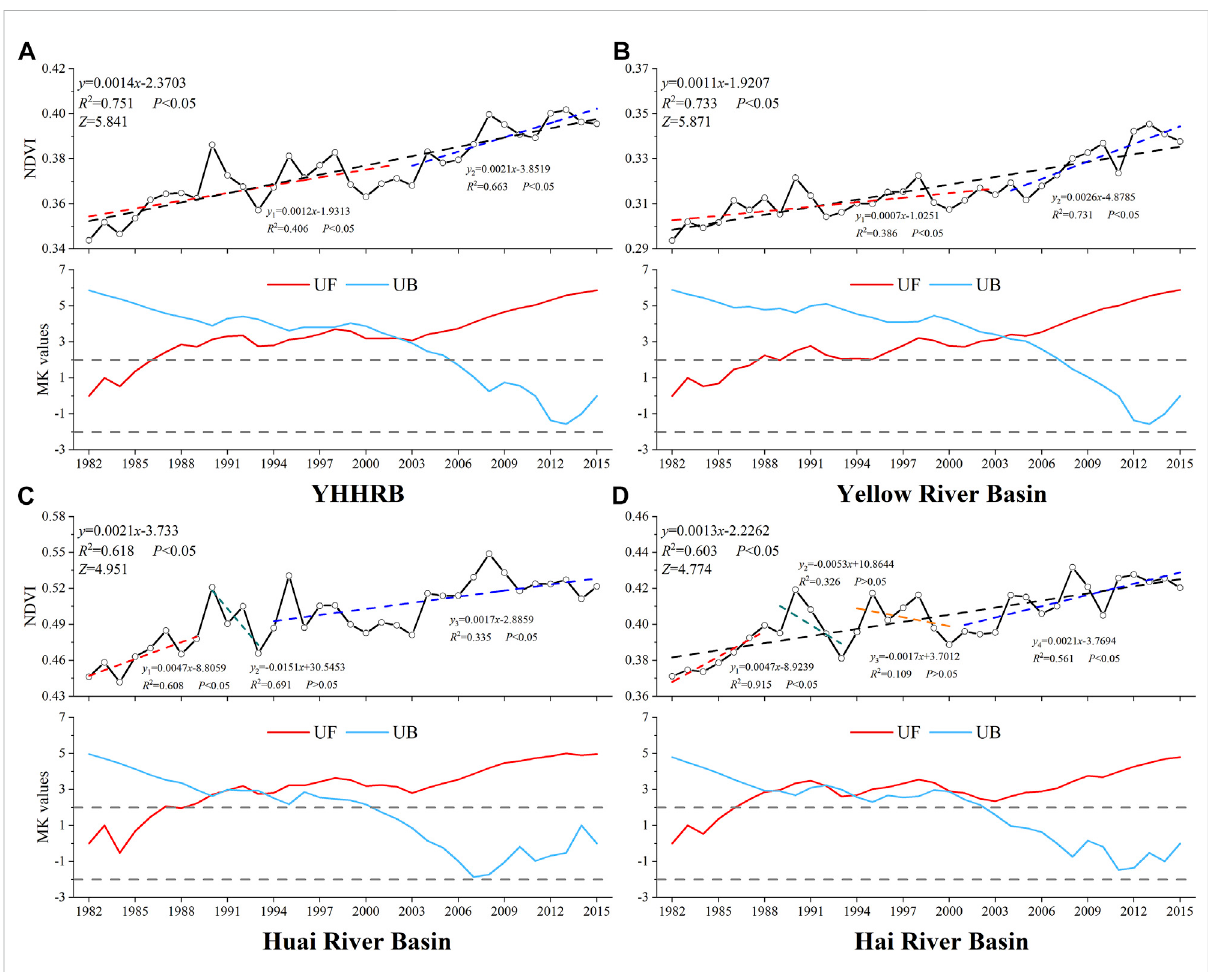
FIGURE 3 Interannual variation of the NDVI and sequential Mann – Kendall tests in the YHHRB (A) , Yellow River Basin (B) , Huai River Basin (C) and Hai River Basin (D) from 1982 to 2015. p < 0.05 indicates signi fi cance at the 95% con fi dent level.